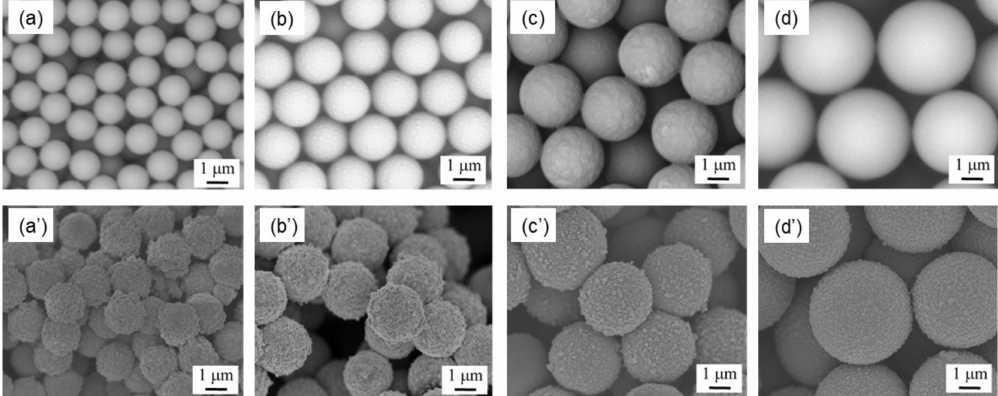
Figure 1. SEM images of PSt microspheres before and after PANI coating: ( a , a’ ) Sample 1; ( b , b’ ) Sample 2; ( c , c’ ) Sample 3; and ( d , d’ ) Sample 4. Table 1. Average diameter (AD) and coefficient of variation (CV) of PSt- and PANI-coated PSt microspheres, and estimated thickness of PANI shell layer.